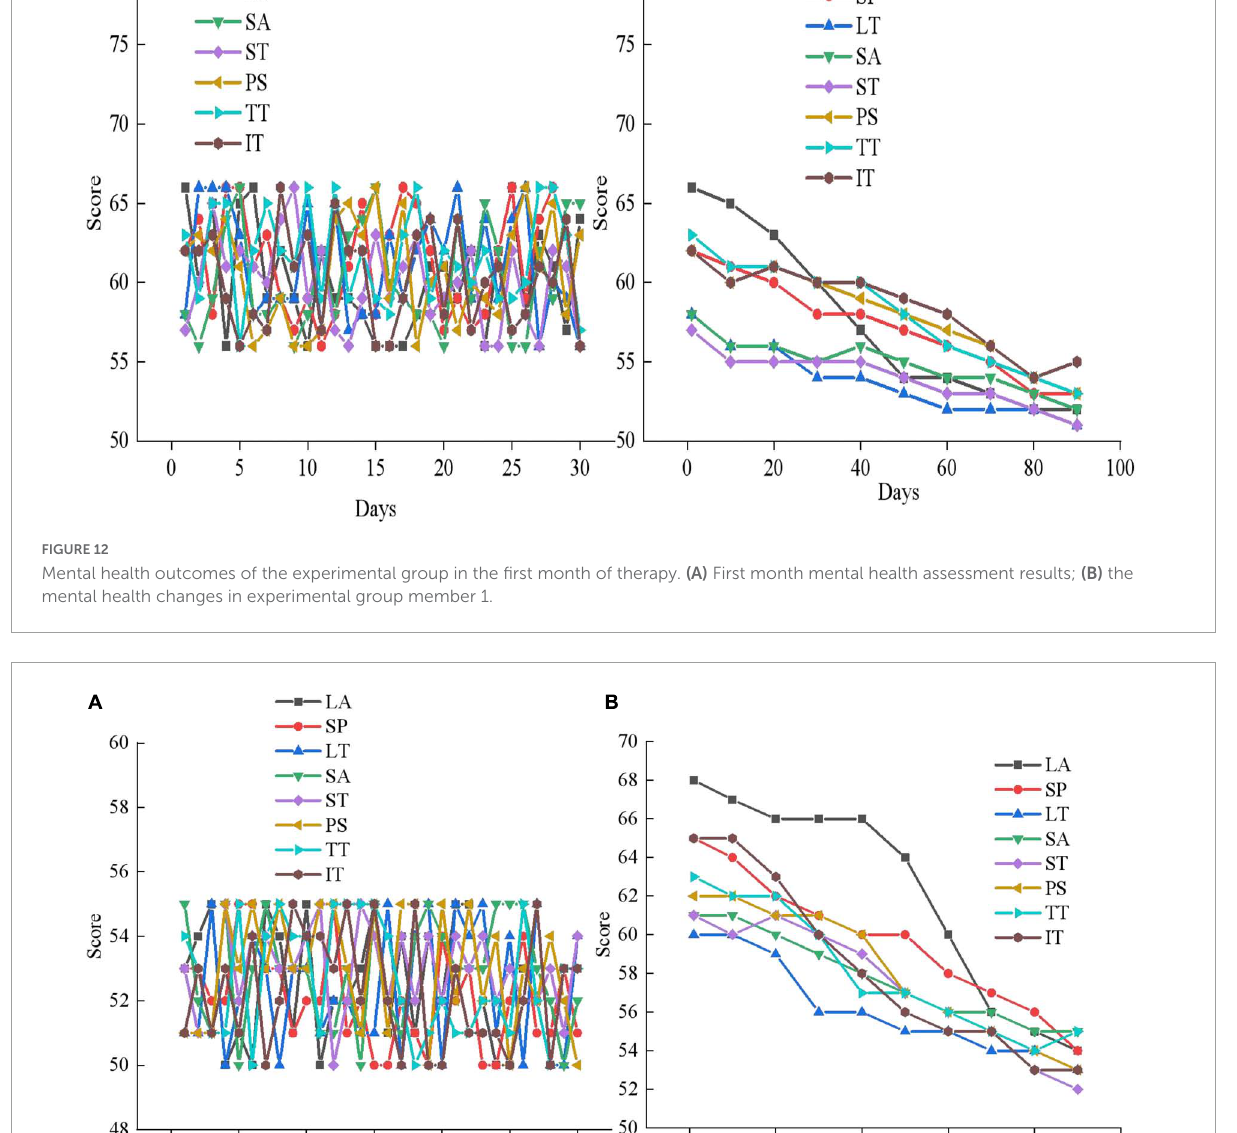
and statistically analyzed. People with 11–14 years old are in the juvenile period, whereas those with 15–18 years old are in the early youth period. The results are shown in The mental health problems of adolescents occur during the early youth. The “healthy” adolescents are 9.51% more than